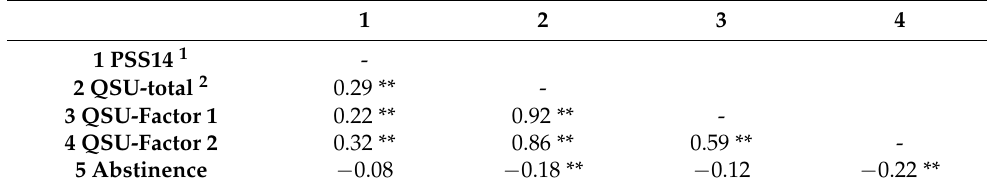
Table 2. Pearson